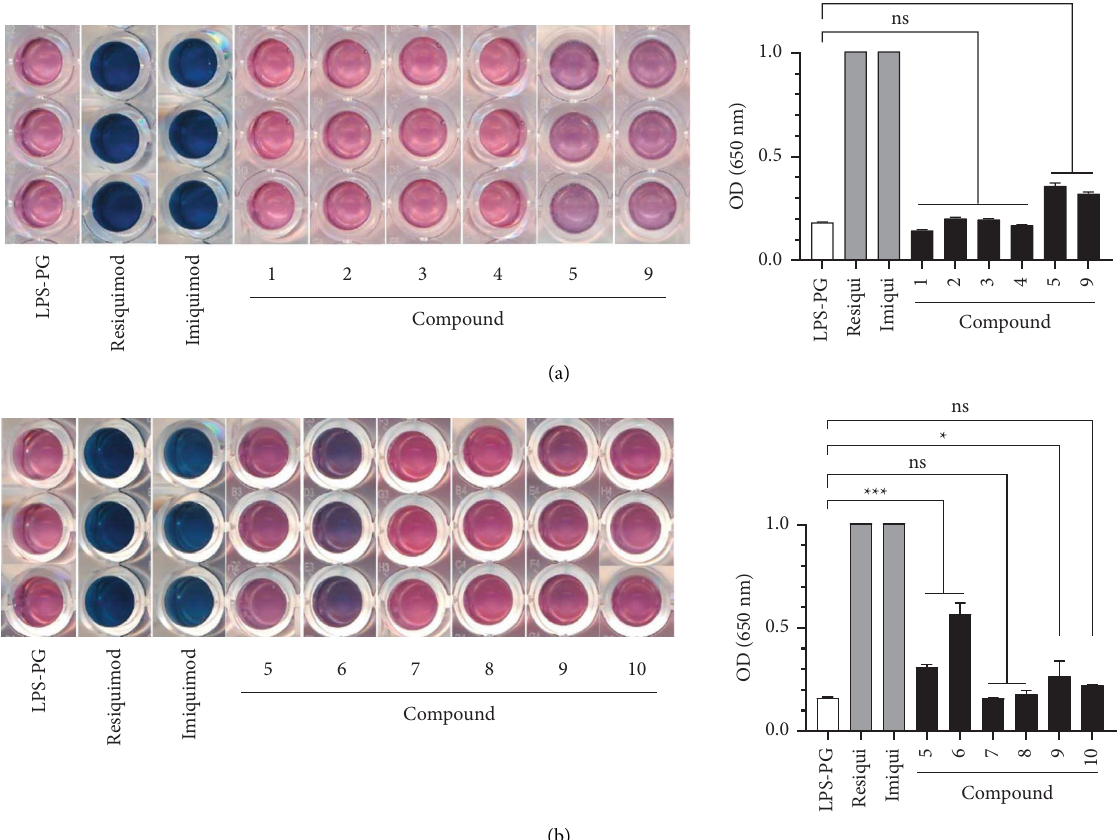
Figure 3: Efect of 3-(5-hydroxyphenyl)-5-phenyl-2-pyrazolines derivatives on TLR7 agonist activity: (a) HEK-Blue hTLR7 reporter cells were treated with compounds 1 , 2 , 3 , 4 , 5 , and 9 (top panel) or compounds 5 , 6 , 7 , 8 , 9 , and 10 (bottom panel) at 50 μ M for 24h and (b) TLR7-induced secreted embryonic alkaline phosphatase (SEAP) reporter activities were measured with the culture supernatant by reading the OD at 650nm using a VersaMax microplate reader. LPS-PG was used as a negative control, whereas 2.9 μ M resiquimod and imiquimod were used as positive controls. ns: not signifcant, ∗ p < 0 . 05 and ∗∗∗ p < 0 .